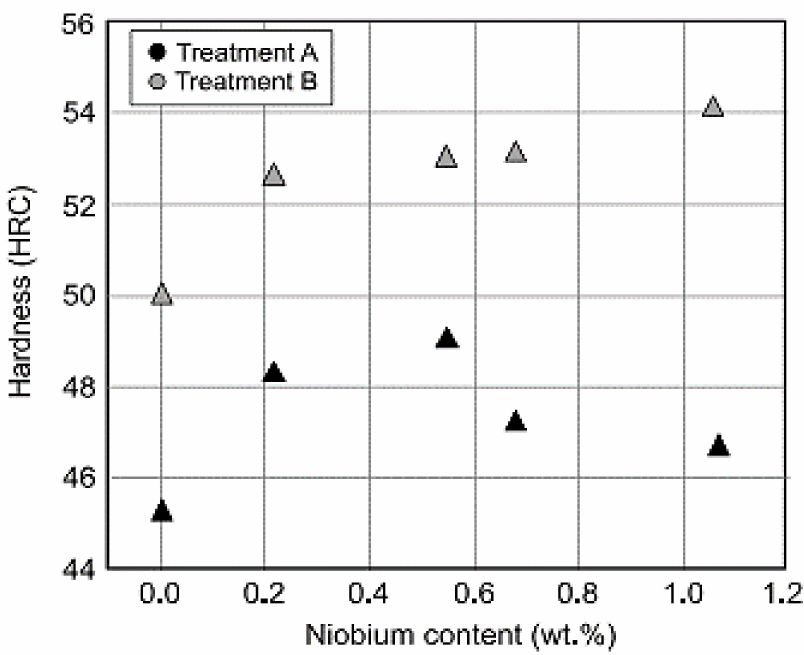
Figure 40. The effectiveness of niobium inclusion and austempering temperature on hardness of the samples [41].